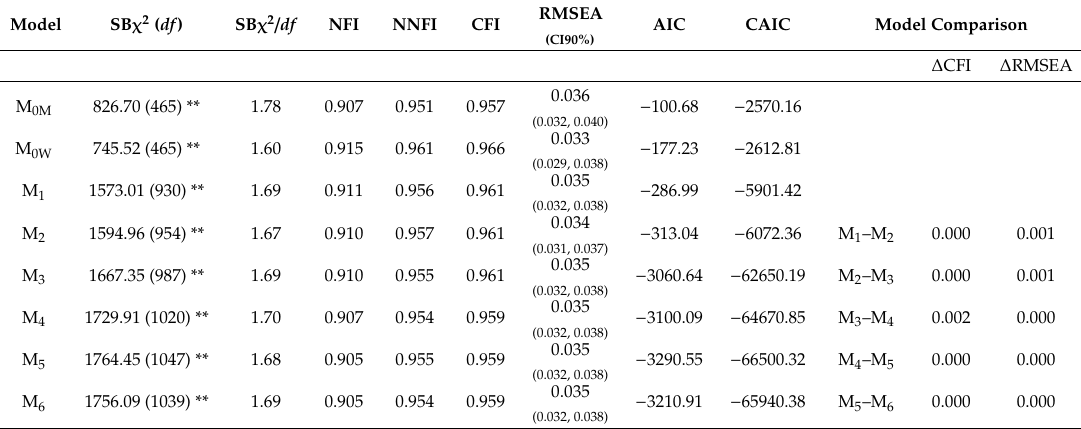
Table 5. Goodness-of-fit indices and invariance tests between men and women for the PACE-33. Model SB χ 2 ( df ) SB χ 2 /